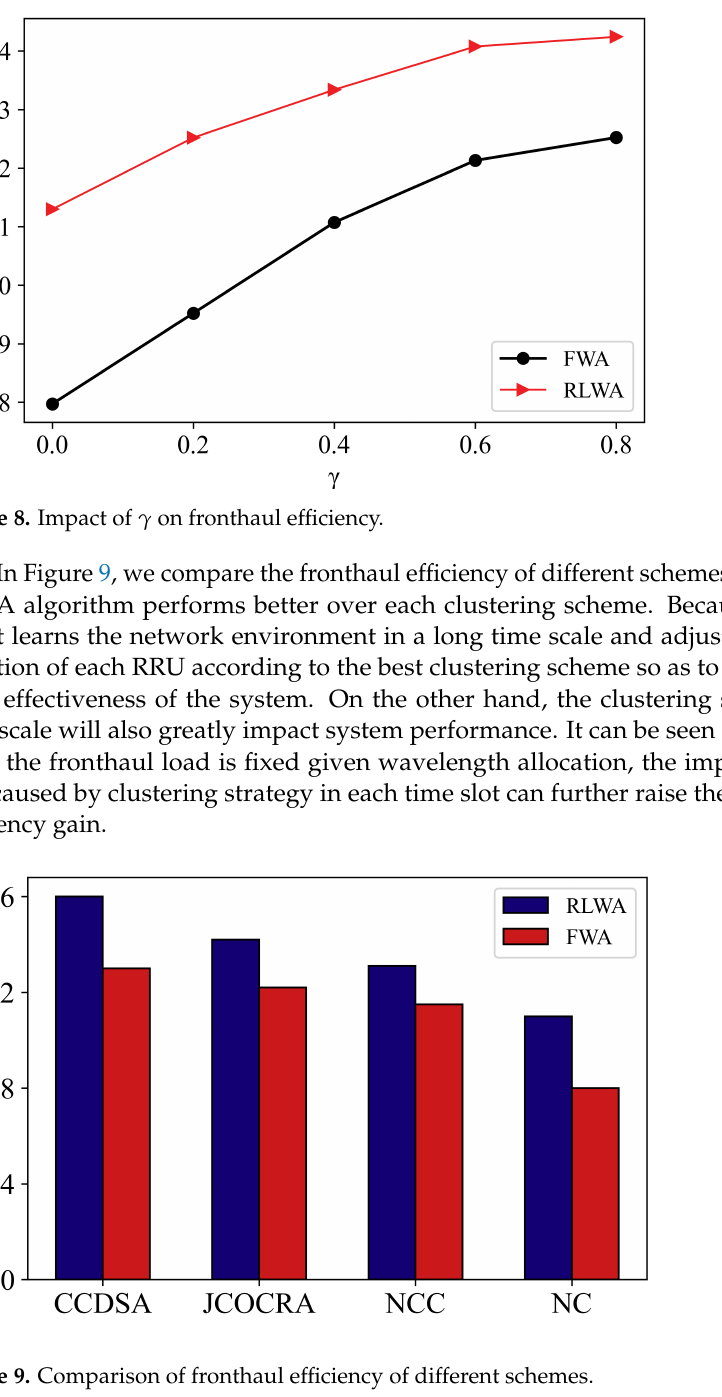
Figure 9. Comparison of fronthaul efficiency of different